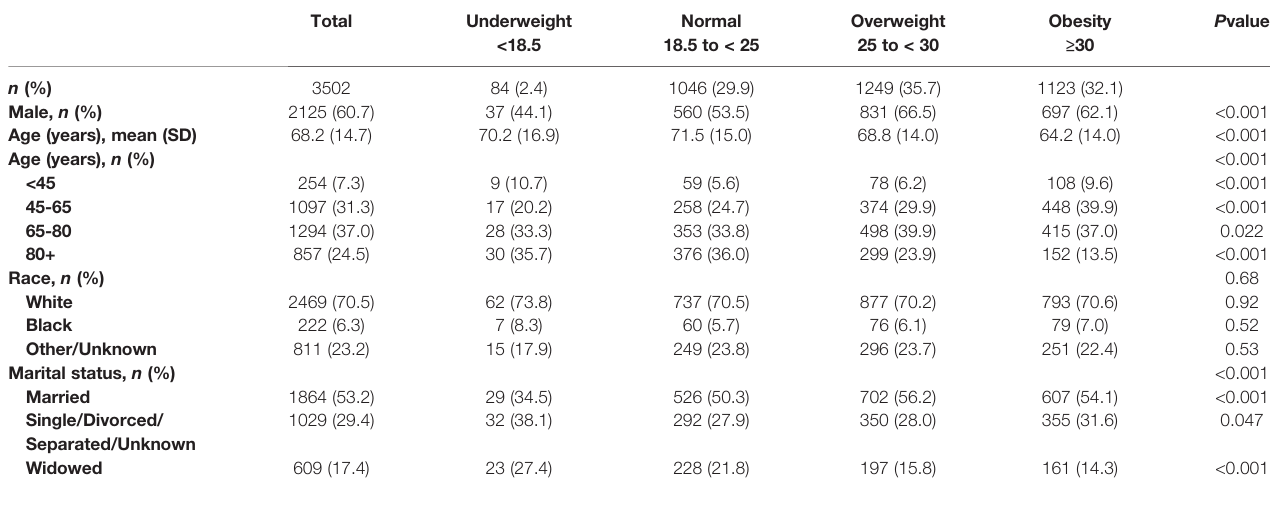
TABLE 1 | Univariate analysis of demographic characteristics by BMI